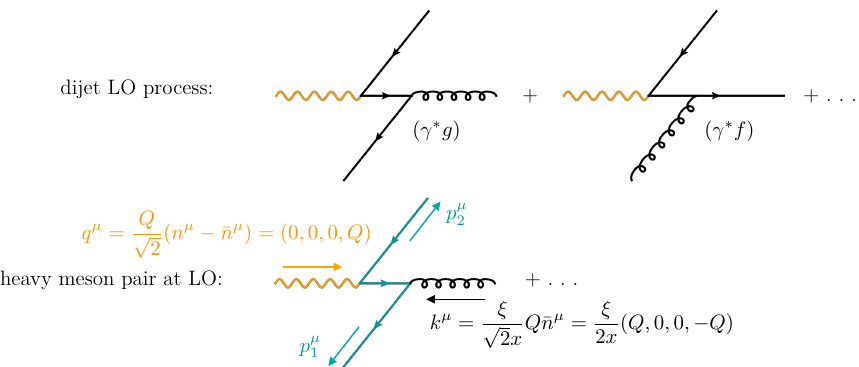
Figure 1. Example LO diagrams for the two processes. The momenta q µ and k µ (corresponding to the photon and incoming parton momenta respectively) are expressed in the Breit